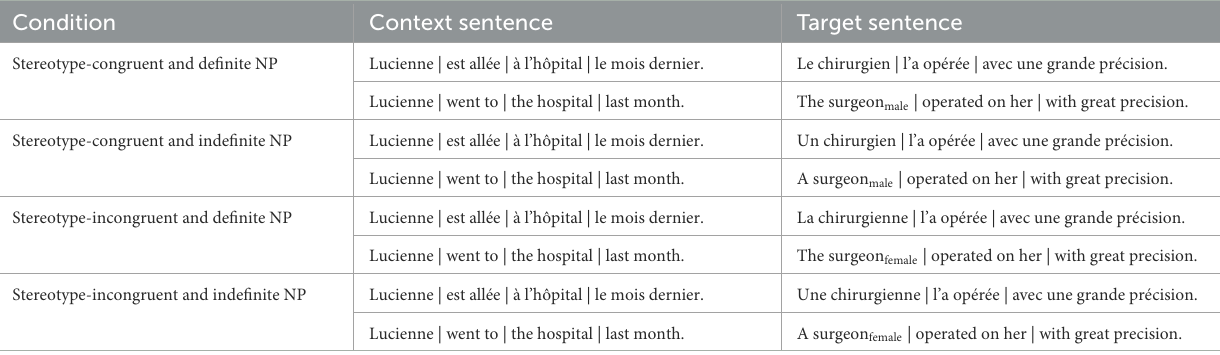
TABLE 1 Example of a stimulus of Experiment 1 in the four experimental